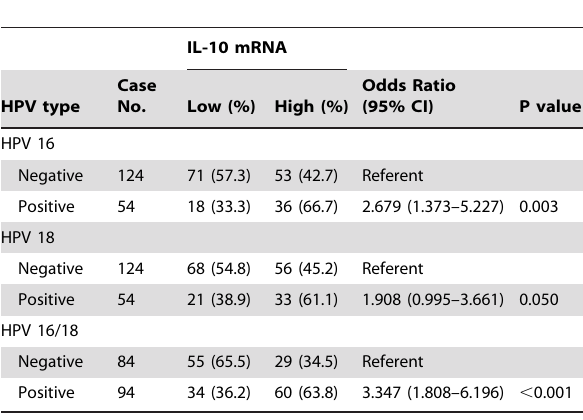
Table 2. Comparison of IL-10 mRNA expression levels between HPV-positive and HPV–negative OSCC patients.